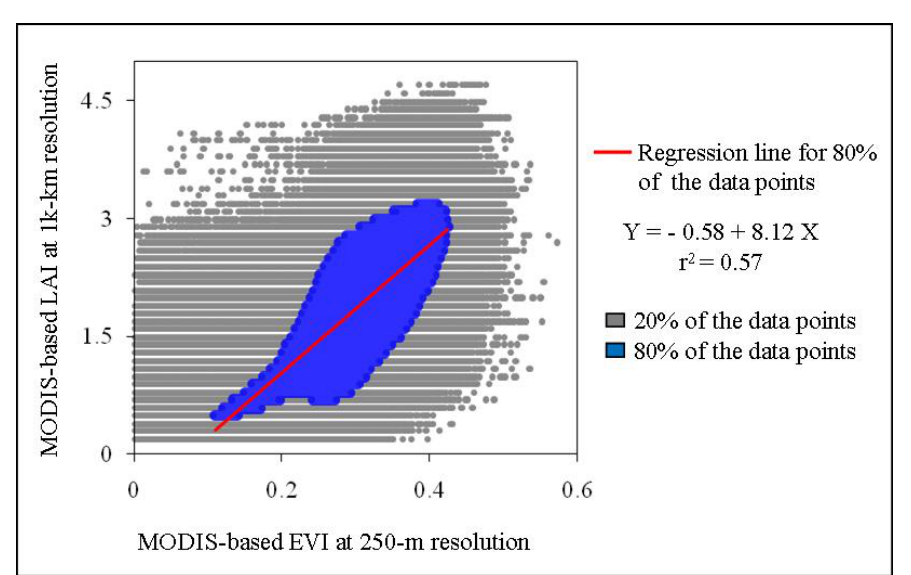
Figure 2. Scatterplot of cell-to-cell comparison of growing season (2006) averages for LAI and EVI for needleleaf forests; F-statistic = 2,120.31 and p <